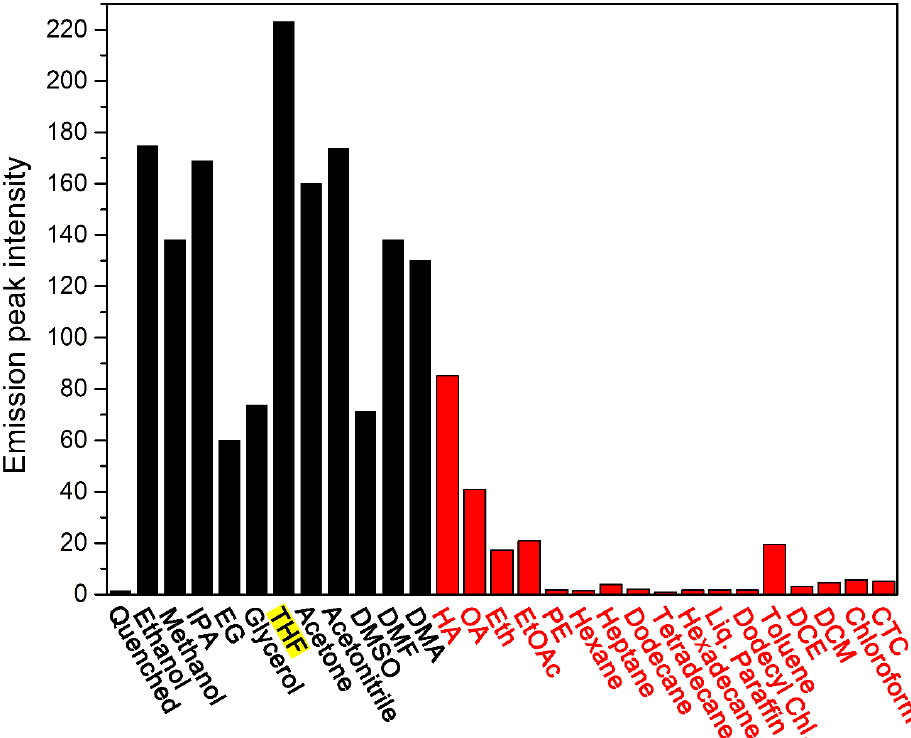
Figure 7. Comparison histogram of typical fluorescence emission intensity against the systems with different organic liquids. The black and red bars represent the systems with water–soluble and –insoluble organic liquids,